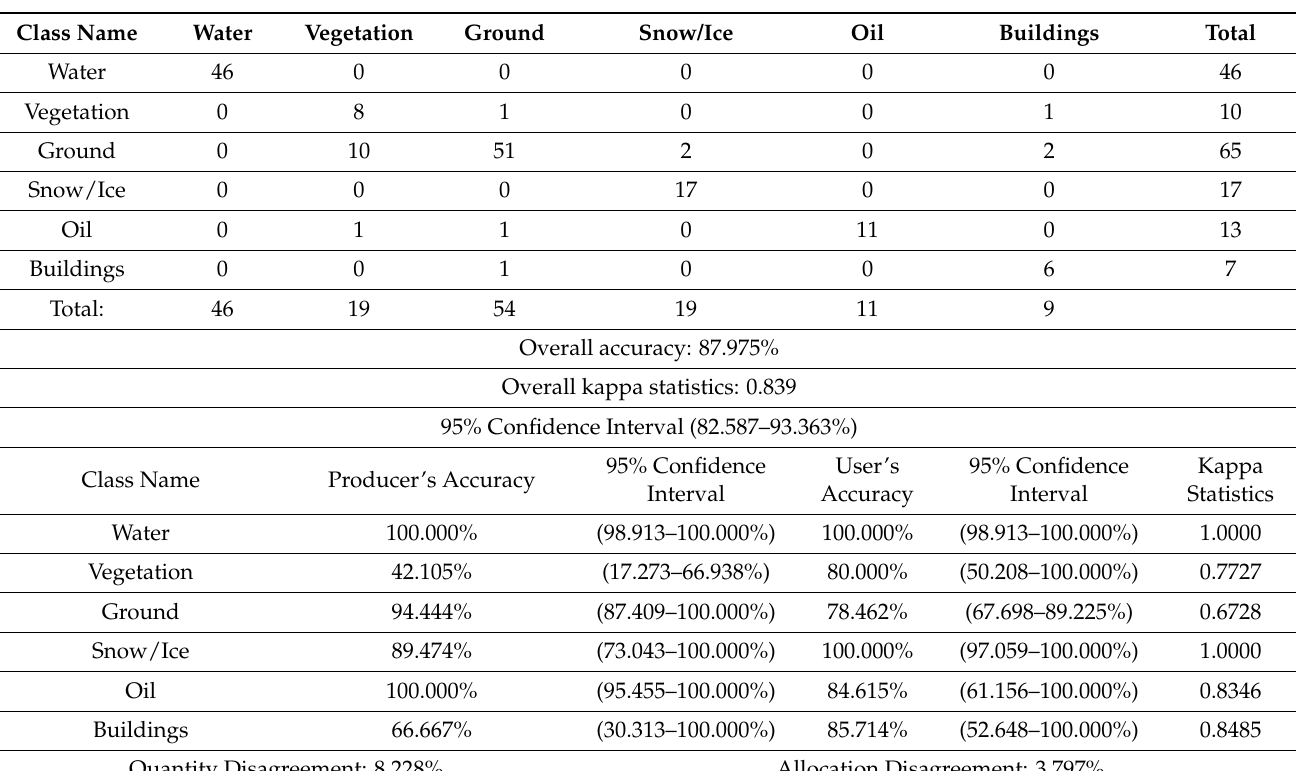
Table 2. Confusion Matrix and Accuracy statistics for SVM